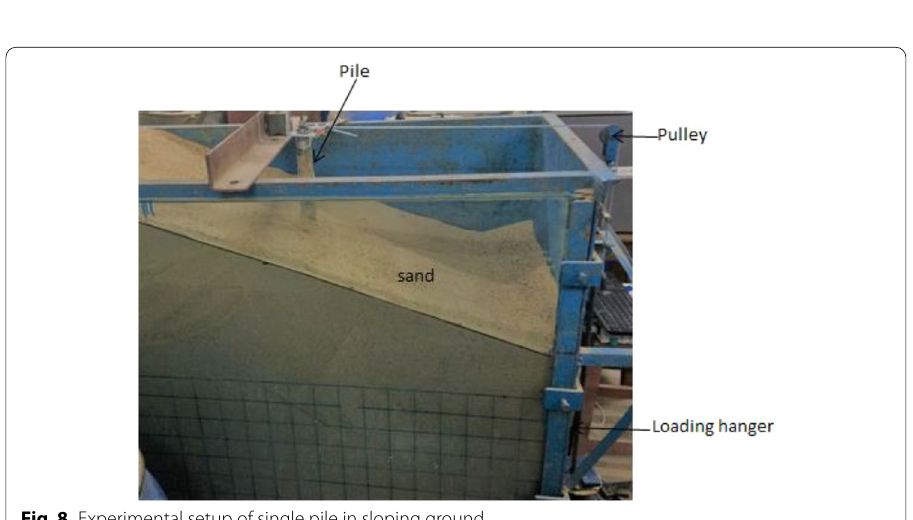
Fig. 8 Experimental setup of single pile in sloping